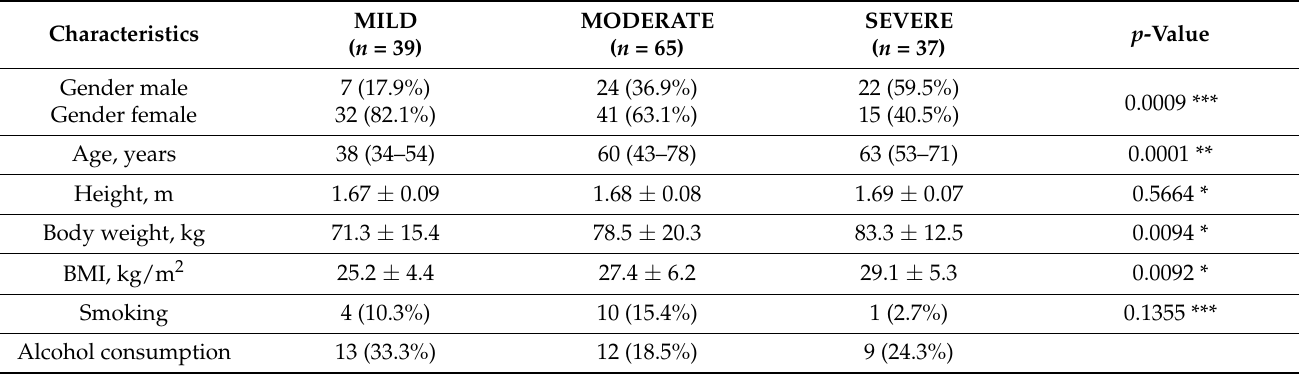
Table 1. Characteristics of